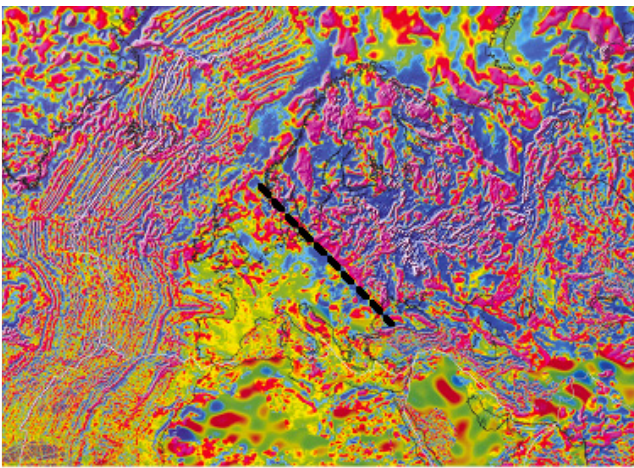
Figure 6. European section of the World Digital Magnetic Anomaly Map (WDMAM) [Korhonen et al. 2007]. The dotted line marks the transition zone to the 'Russian Platform' in the NE. This zone of changing magnetic performance turns out also from the European declination 2006 map presented in Figure